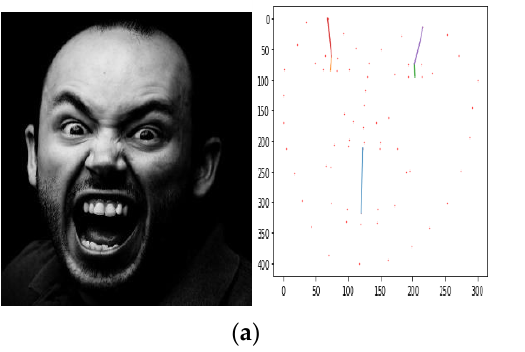
Figure 5. Face landmarks and feature representation of two emotions (source: Helen dataset): ( a ) “angry face” image; ( b ) “happy face” image.